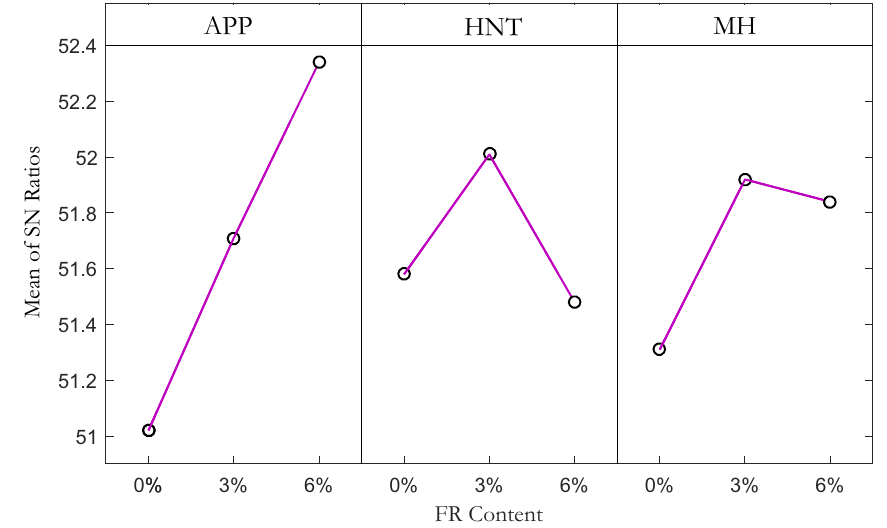
Figure 2: Main e ff ects plot for S/N ratios for burning time.